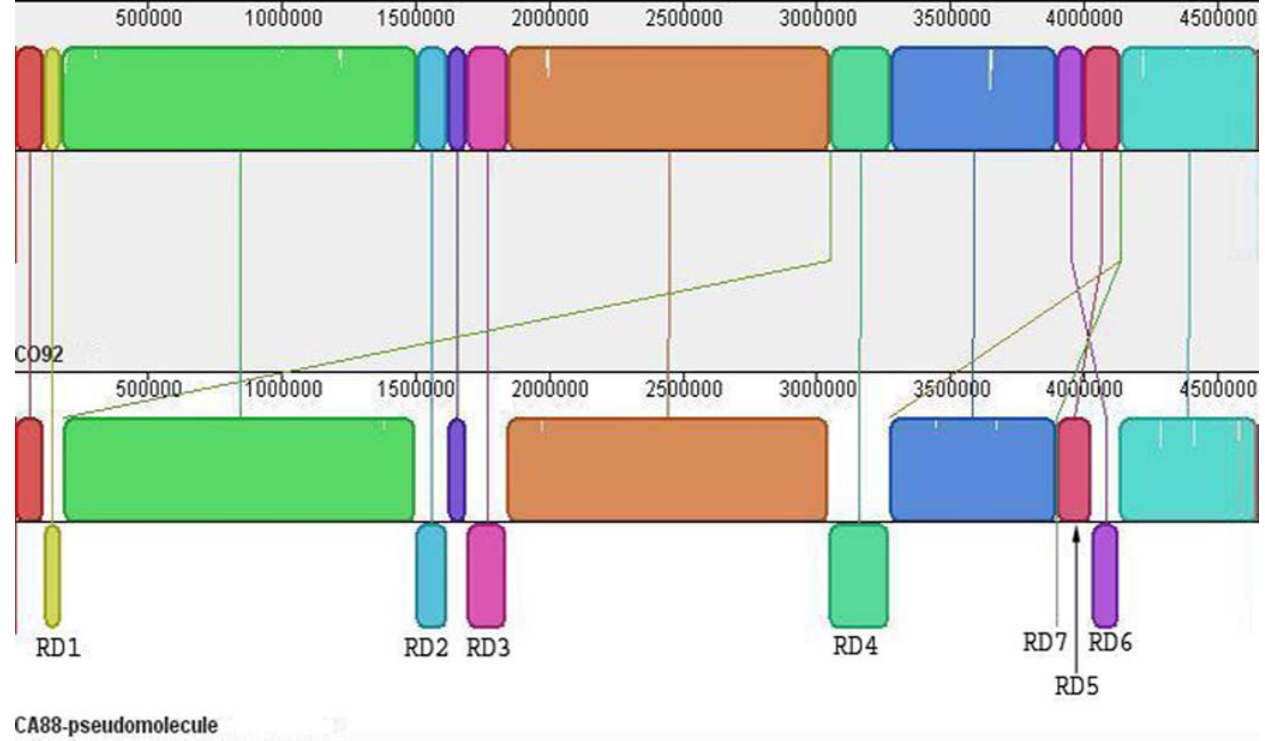
Figure 1. A whole-genome comparison between Y.pestisstrains CO92 (top) and CA88 (bottom) using MAUVE. MAUVE found 15 LCBs shared between CO92 and CA88, six of which are inverted and one of which is rearranged. The seven large regions of difference are indicated. Some LCBs are too small to display on this figure and are shown by long diagonal lines connecting the genomes.